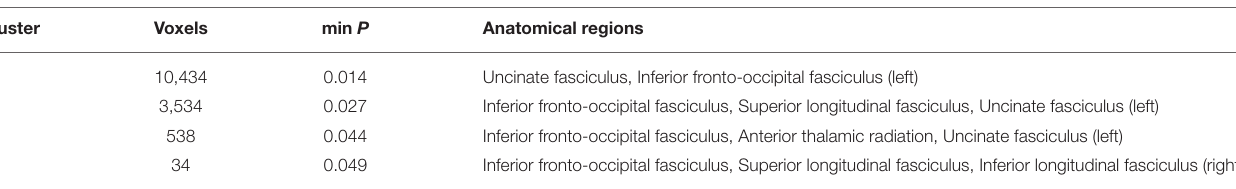
while the feeder and local connection strengths did not change ( Figure 4B ). In addition, the rich club connection strength of the